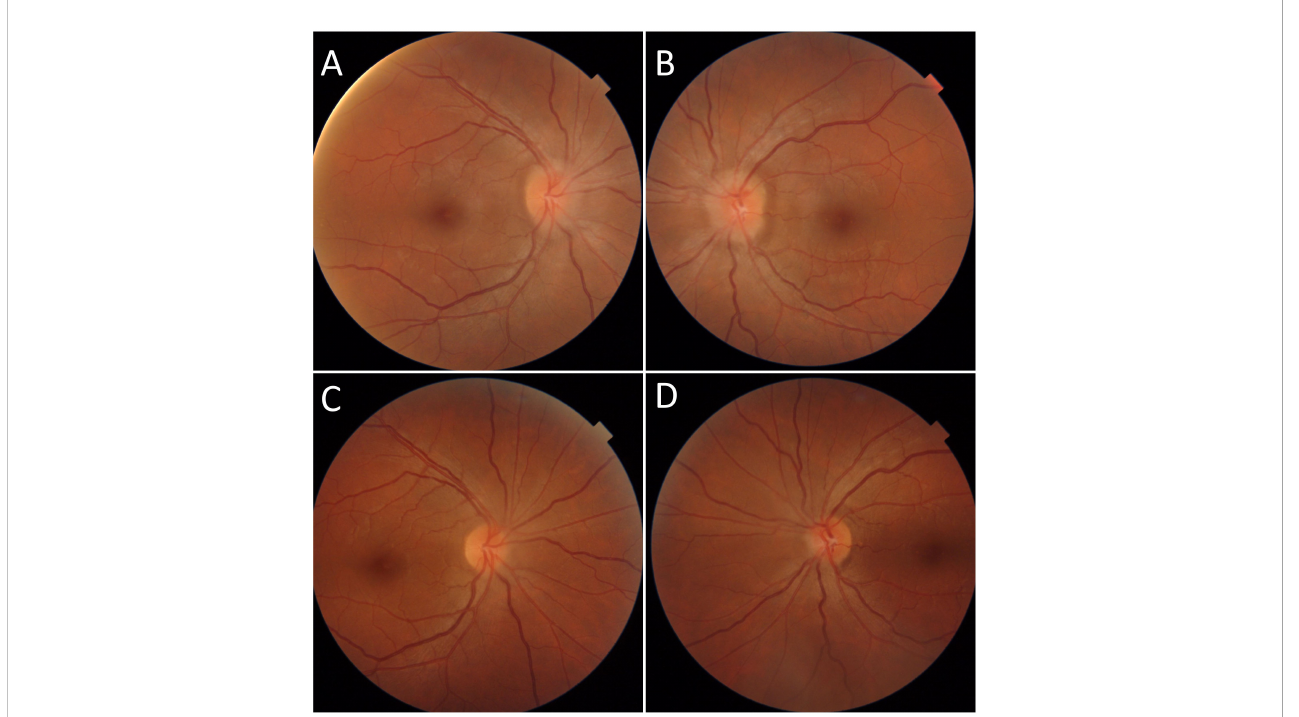
FIGURE 5 Case number 11. Fundus photographs of a 39-year-old female with SLE and chronic hydroxychloroquine use for 14 years. (A) There is Frisen grade 1 papilledema of the right eye and (B) Frisen grade 2 papilledema of the left eye. A negative MRI and increased cranial pressure yielded the diagnosis if IIH. Papilledema resolved following treatment with oral acetazolamide (C, D)